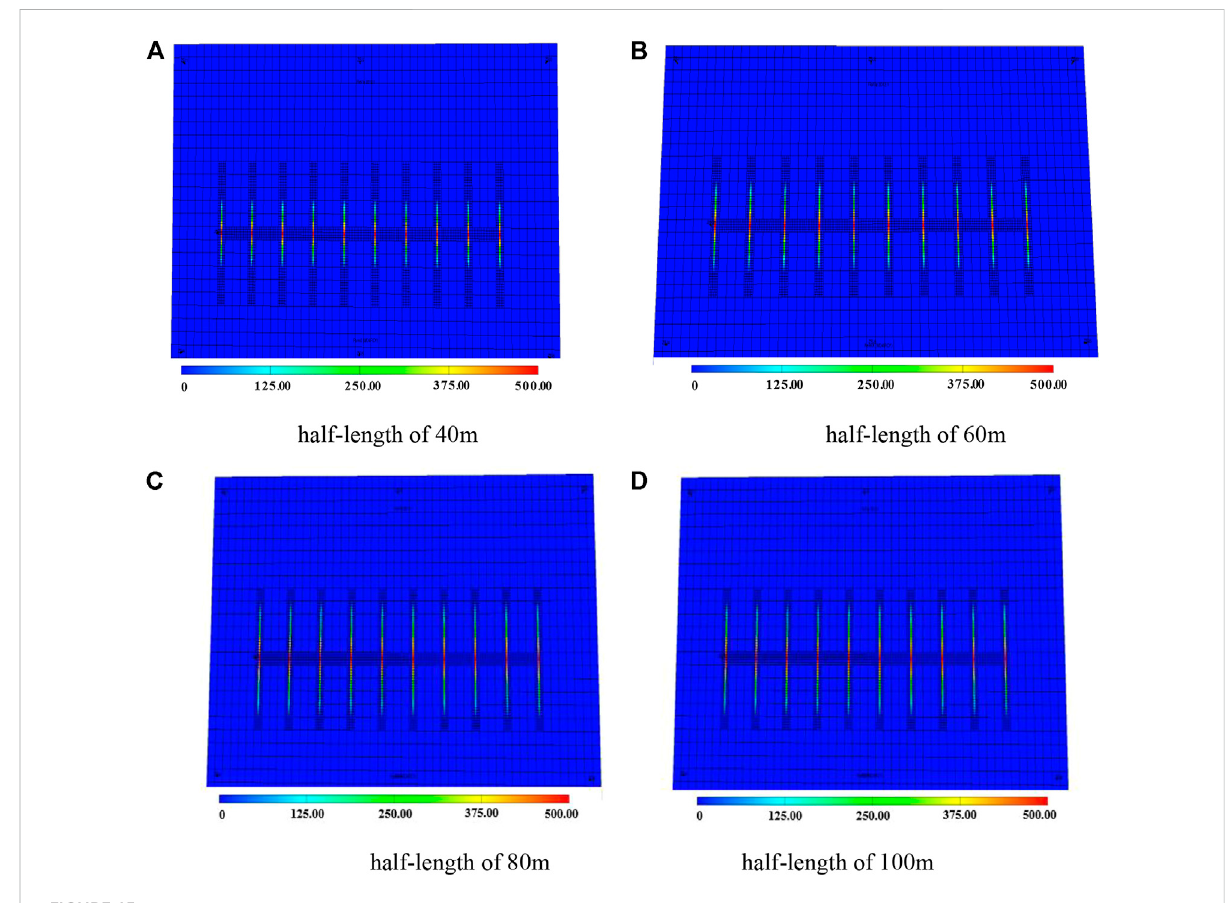
FIGURE 15 In fl uence of different fracture half-lengths on reservoir seepage fi eld.